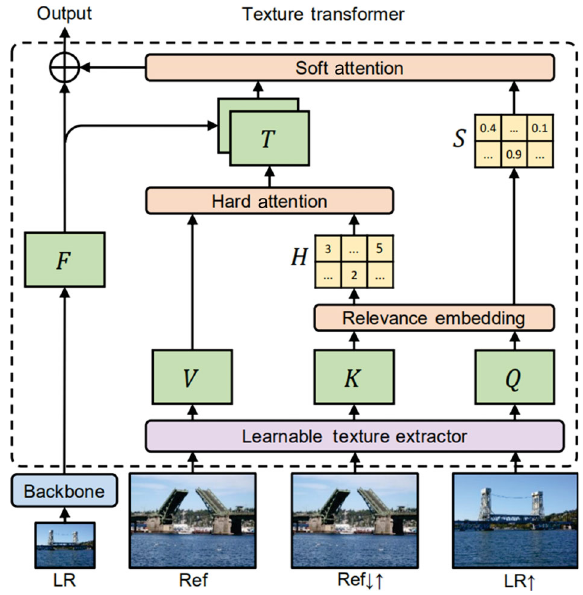
Fig. 18 Model overview of TTSR. Reproduced with permission from Ref. [33], c (cid:2) IEEE